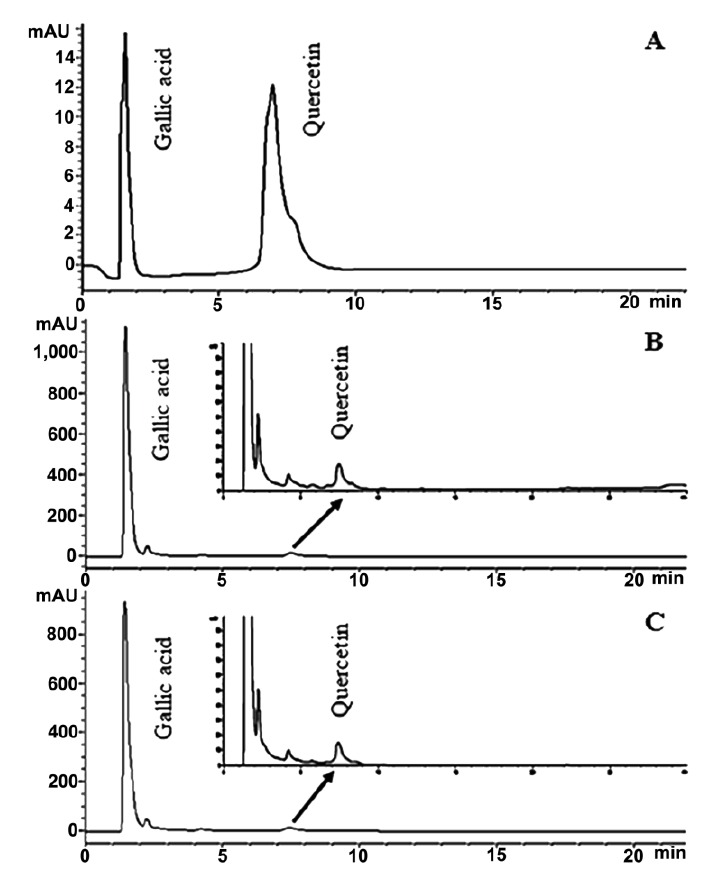
Figure 4. HPLC chromatogram of gallic acid and quercetin ( A ) found in royal jelly sample RJ-LP1 ( B ) and RJ-CM1 ( C ). and RJ-CM1 ( C